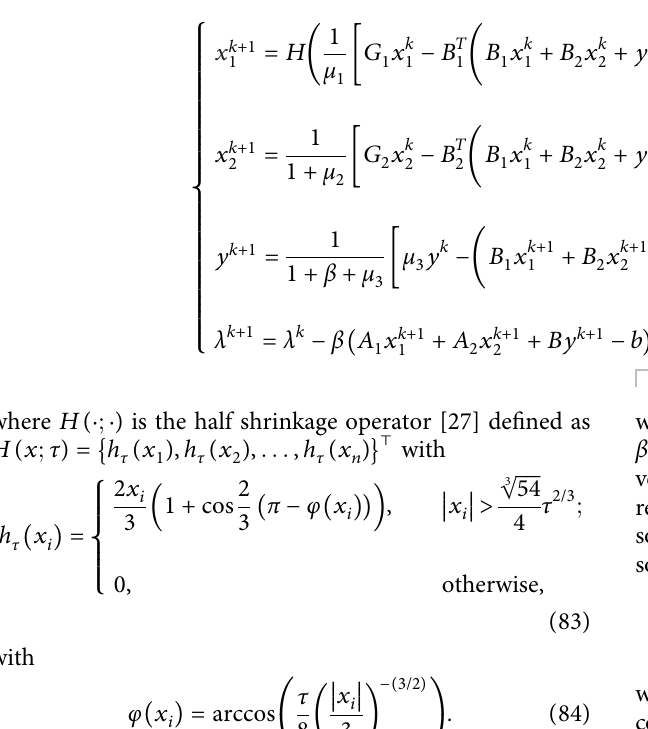
Figure 1: n 1 � 1500, n 2 � 1500, and m �